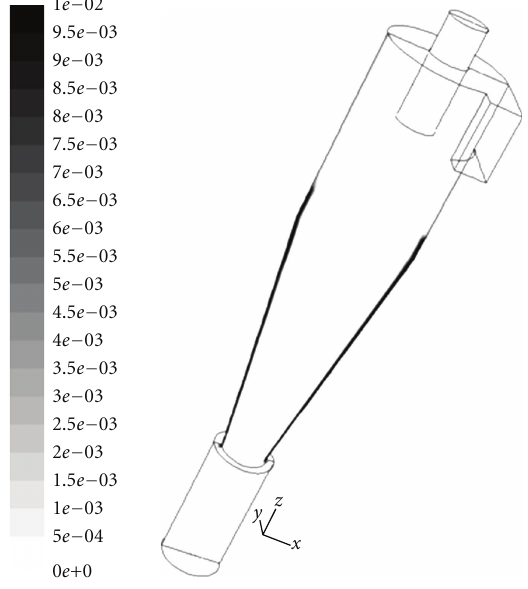
Figure 10: Particles volume fraction at y = 0 (1kg/m 3 ).